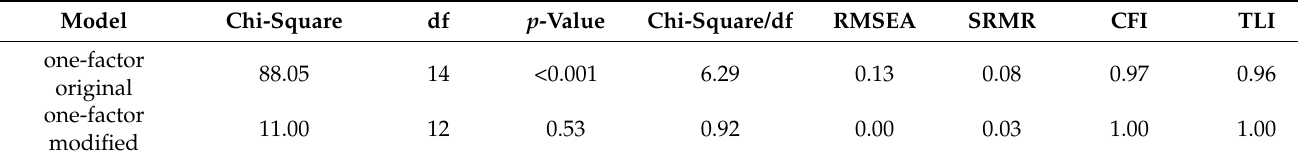
Table 1. Results of the confirmatory factor analysis of QoL (N =